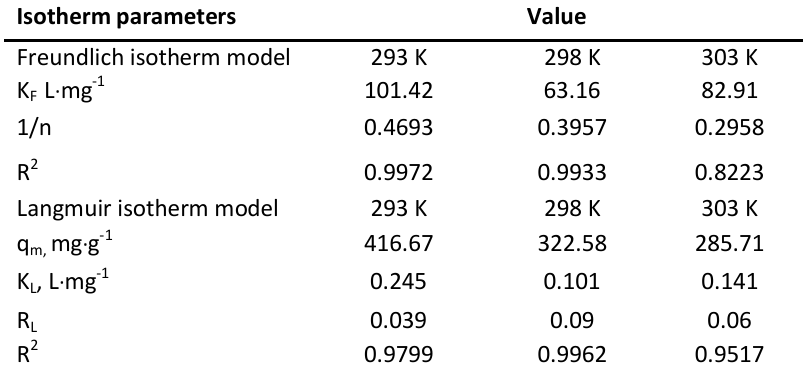
Table 1. Isotherm parameters of adsorption of reactive blue dye on